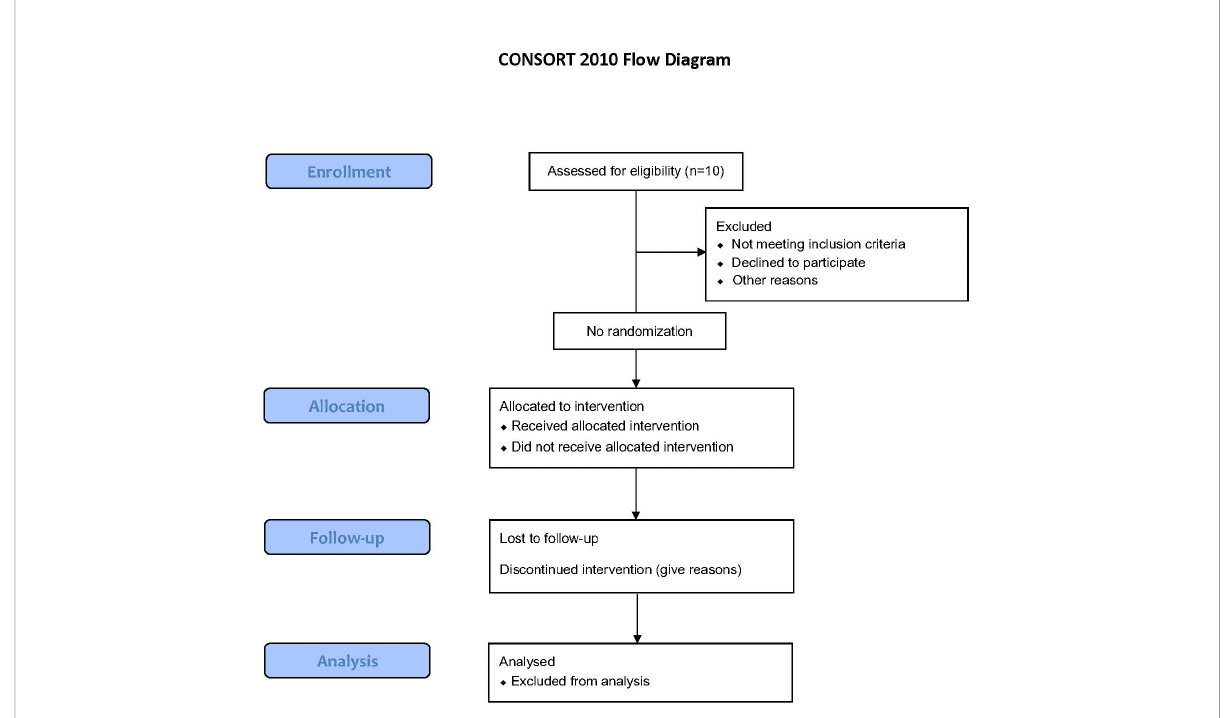
FIGURE 3 Flow Diagram for the T-RAD study created using the CONSORT 2010 Flow